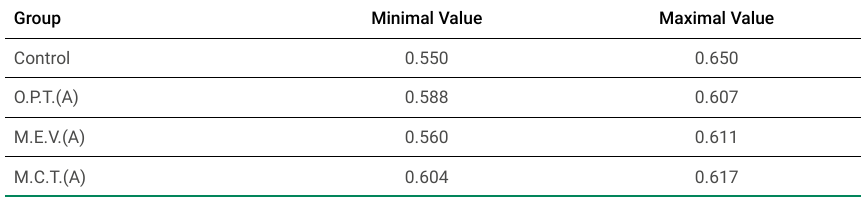
Table 2. Evaluations average. The provided company CAD (control) was inserted on the first line. The second, third and fourth line were the groups values.